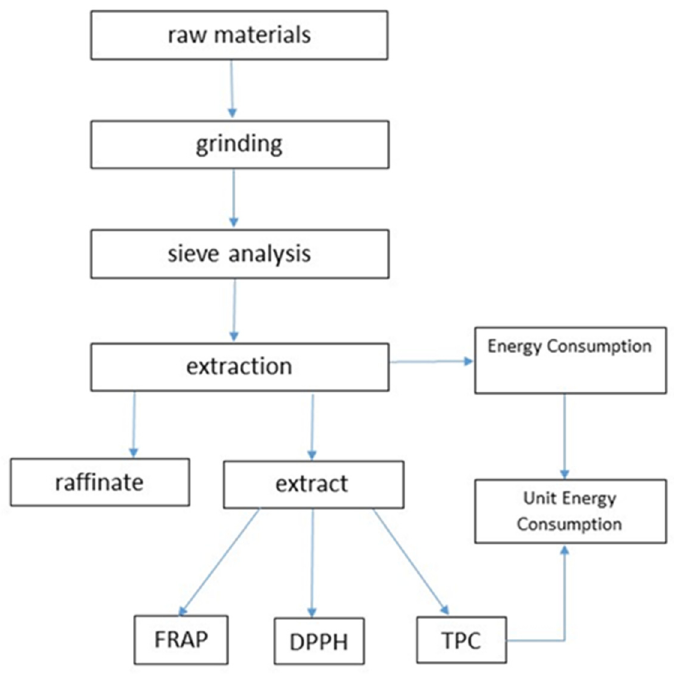
Figure 1. Scheme of the performed research (FRAP—ferric reducing antioxidant power assay, DPPH—2,2 ′‐ diphenyl ‐ 1 ‐ picrylhydrazyl radical assay; TPC—the total polyphenols content).